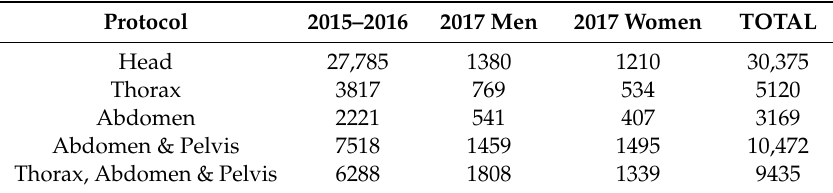
Table 2. Exam distribution by protocol and